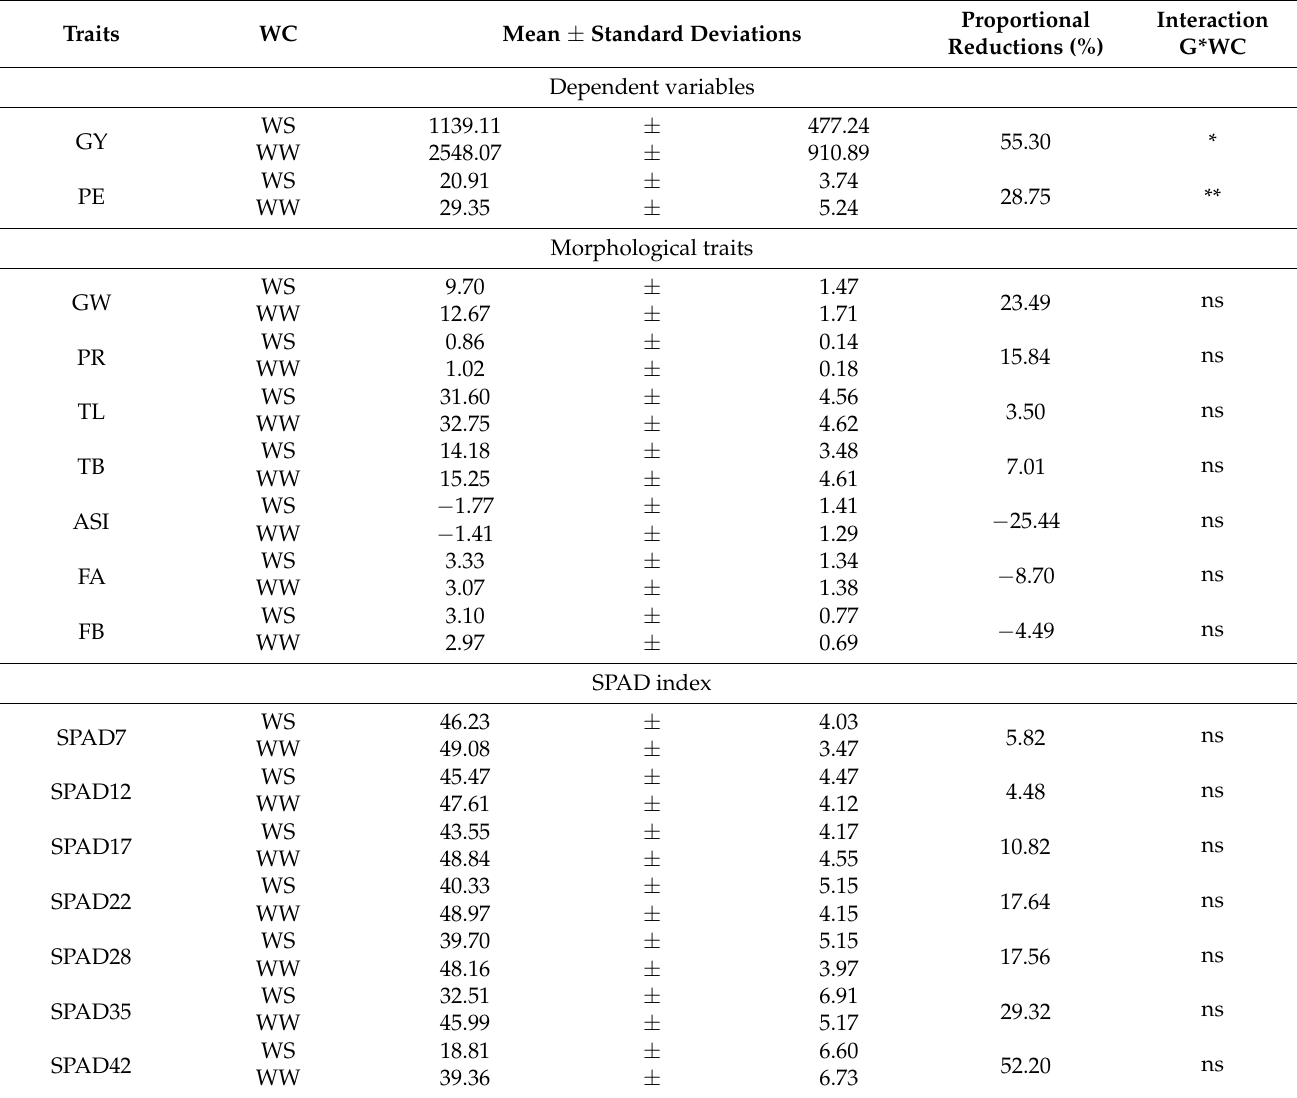
Table 1. Summary of individual and combined analyses of variance and mean estimates, standard deviations and pro- portional reductions under two water conditions (WS and WW conditions) of the dependent variables GY and PE and of the morpho-agronomic and physiological traits (SPAD and NDVI) evaluated on different measurement dates in popcorn inbred